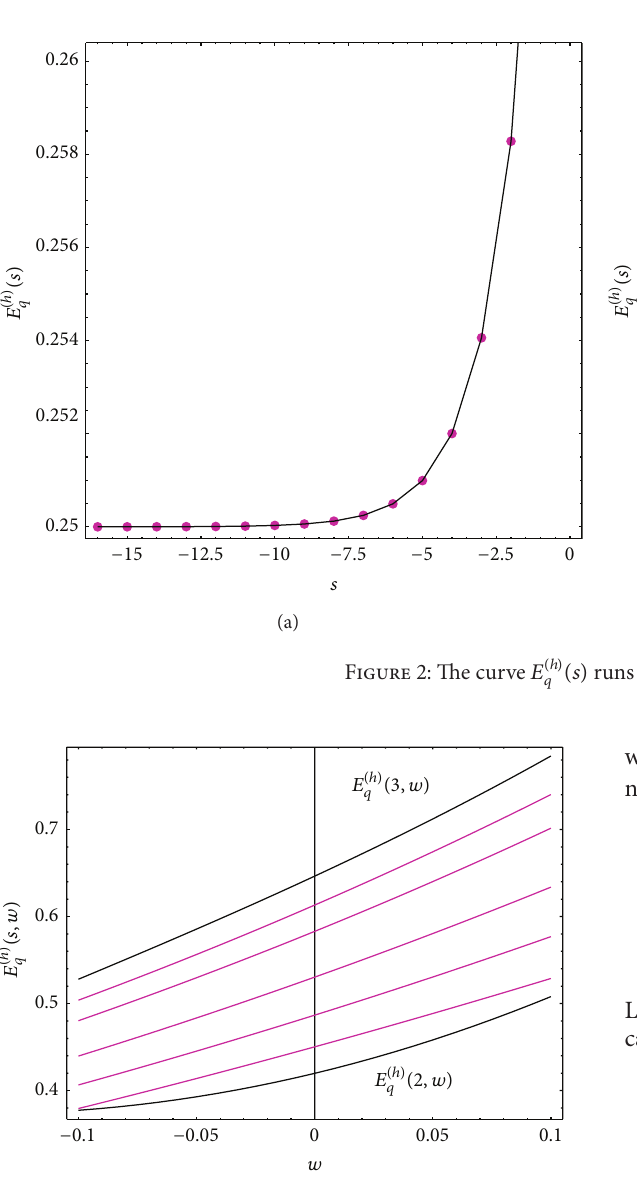
Figure 3: The curve of 𝐸 (ℎ) 𝑞 (𝑠,𝑤) , 2 ≤ 𝑠 ≤ 3 , −0.1 ≤ 𝑤 ≤ 0.1